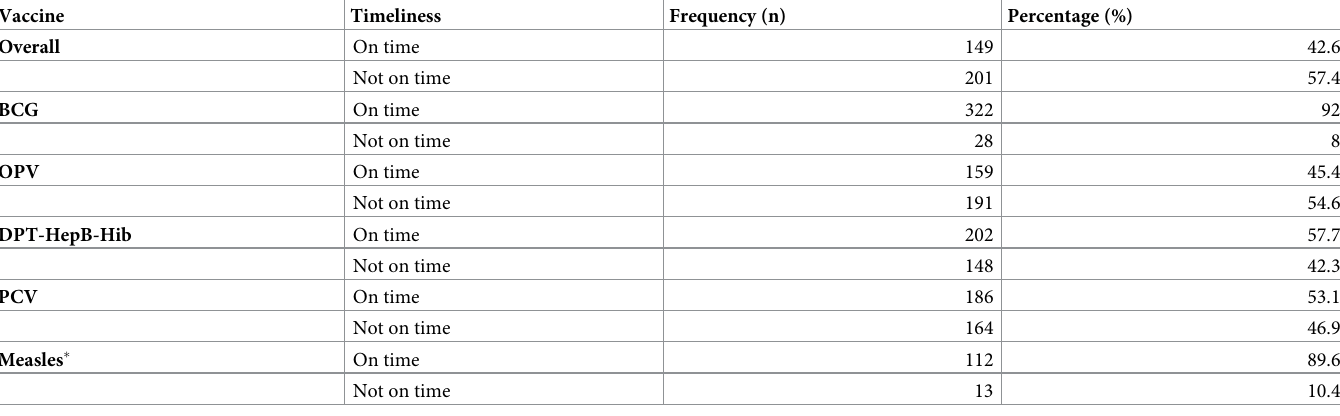
Table 3. Timeliness of vaccination among 350 preterm infants aged 6–24 months at Mulago Hospital, Kampala, Uganda.